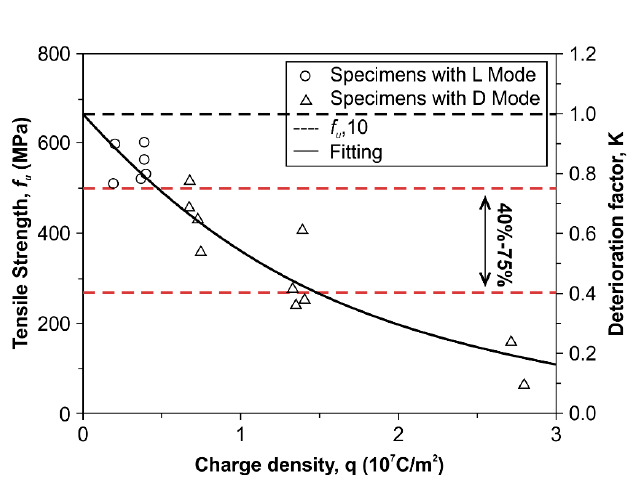
Figure 7. Influence of charge density on tensile strength and deterioration factor for CFRP specimens with anodic polarization in NaOH solution.